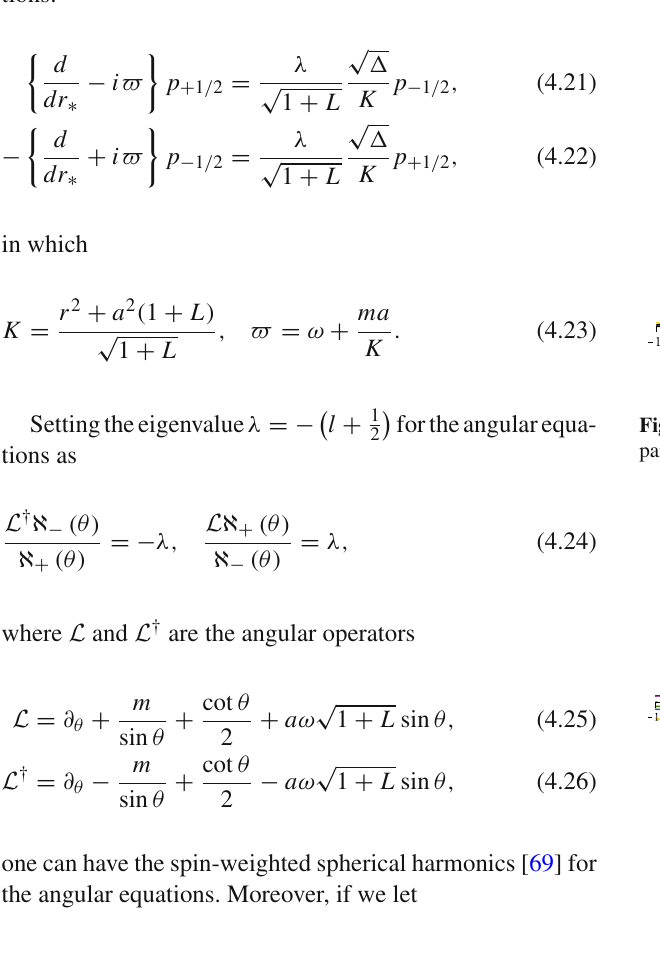
Fig. 3 Plots of V − versus r for fermions spin-( − 1 / 2 ) particles. The ef f physical parameters are chosen as; M = a = 1 , and λ = − 1 .